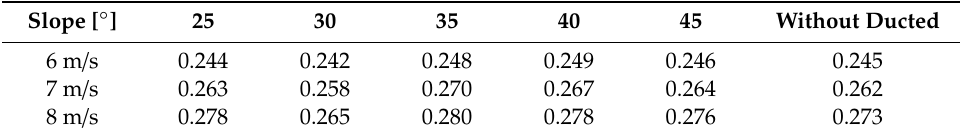
Table 2. Power coe ffi cient values depending on duct slope for airspeed values 6, 7, and 8 m / s on the Table 2. Power coefficient values depending on duct slope for airspeed values 6, 7, and 8 m/s on the 6-ducted blade with the 7 ◦ angle of attack. 6-ducted blade with the 7° angle of attack.